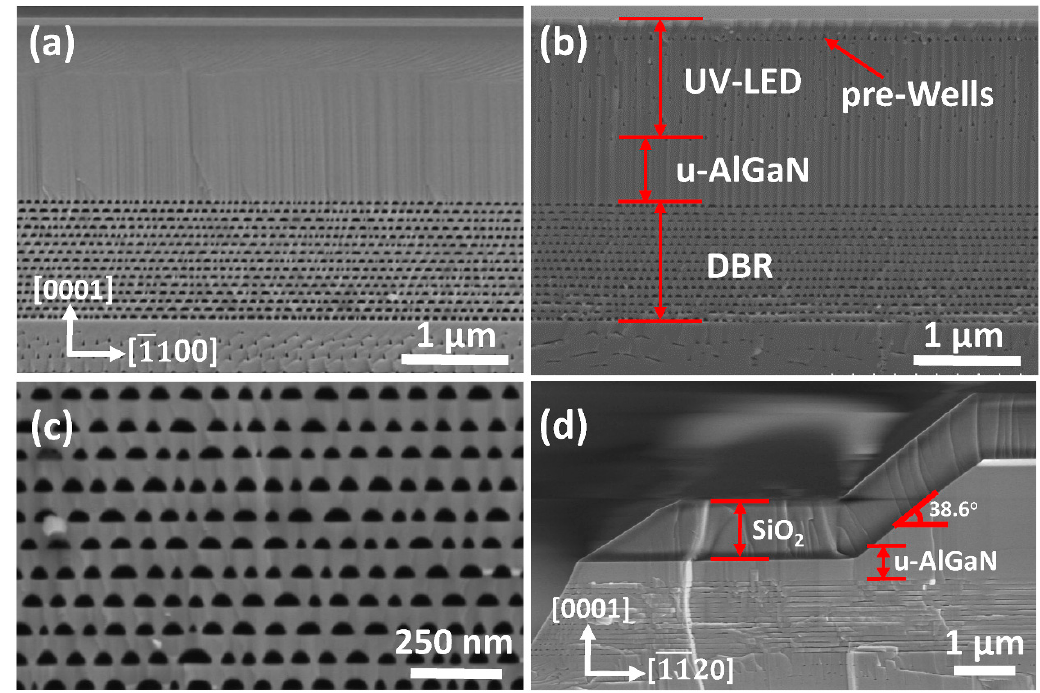
Figure 5. Cross-sectional SEM images of ( a ) DBR-LED with SPL; ( b ) DBR-LED without SPL; ( c ) detailed view of DBR structure in (a); ( d ) detailed view of SPL structure in (a). The observed crystal planes were (11 2 0) planes in (a–c), and ( 1 100) plane in (d).